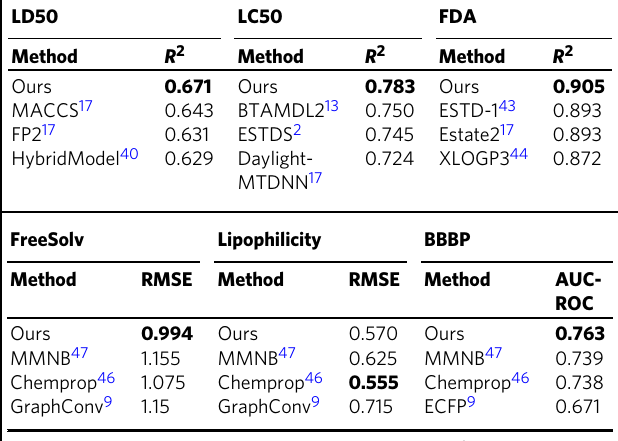
Table 1 Comparison of the best-achieved performance with the reported score on six